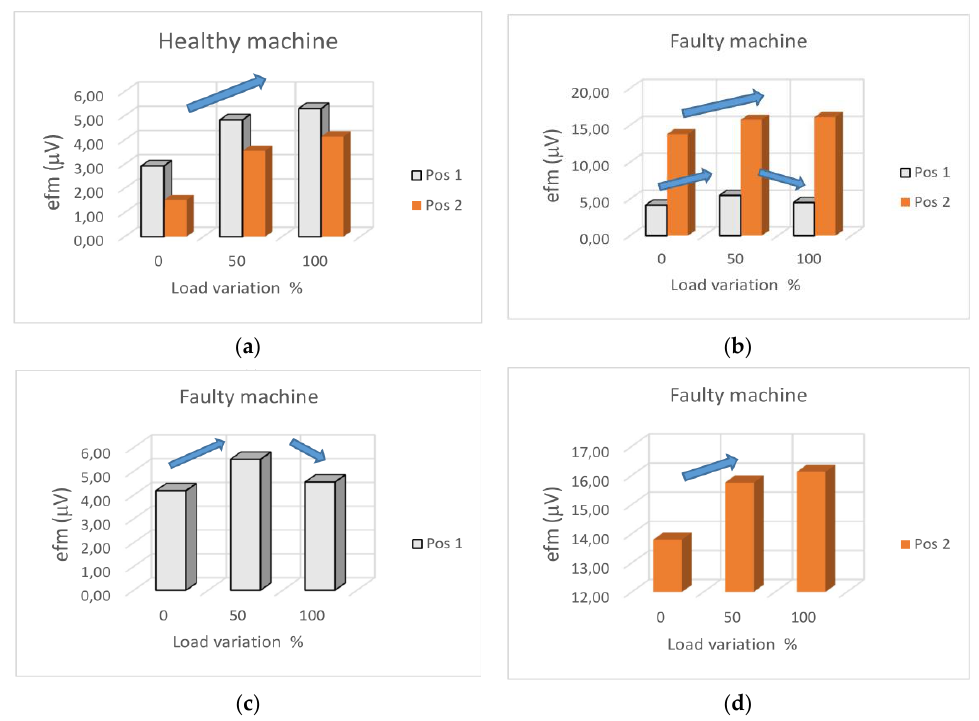
Figure 15. Harmonic components at 750 Hz under both measurement positions for synchronous generator operating at variable load: ( a ) healthy case, ( b ) faulty case, ( c ) faulty case in position 1, ( d ) faulty case in position 2.